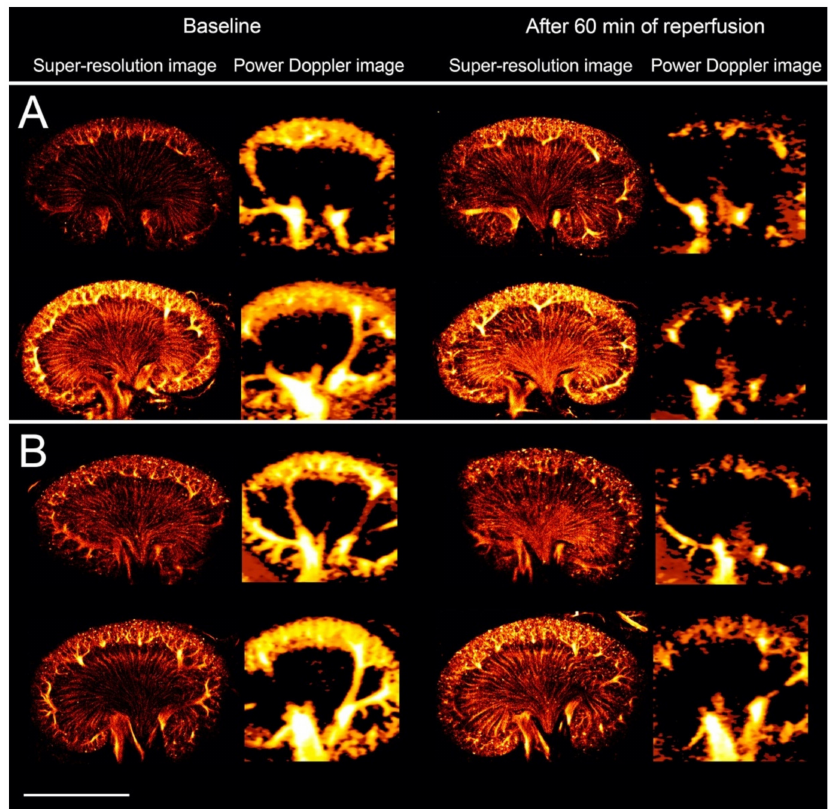
Figure 5. ( A ) Super-resolution (log-scaled) and power Doppler images of two rat kidneys before and after clamping of the renal vein. ( B ) Super-resolution (log-scaled) and power Doppler images of two rat kidneys before and after clamping of the renal artery. In these examples, all the super-resolution images showed a complete refilling of the microvascular bed after 60 min of reperfusion. The power Doppler scans from all animals showed a decreased signal in the cortex after 60 min of reperfusion compared with baseline. Scale bar: 10